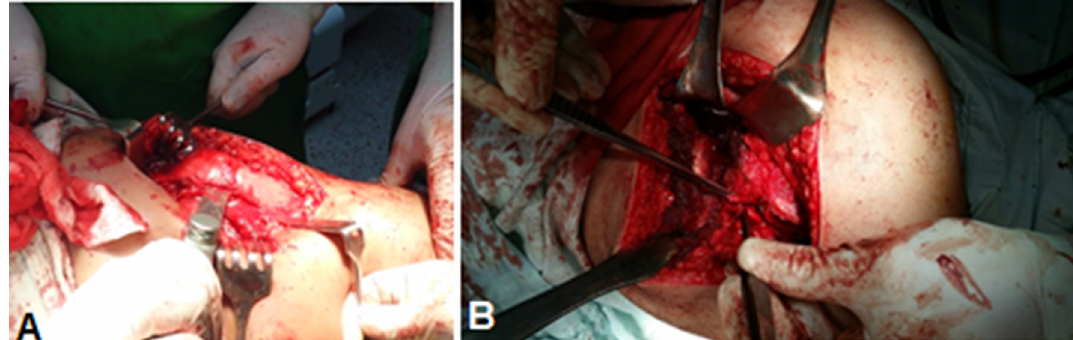
Figure 2. (A) Showing trochanteric osteotomy in patient No. 9. (B) Z-shaped capsulotomy in Lt hip in patient No.